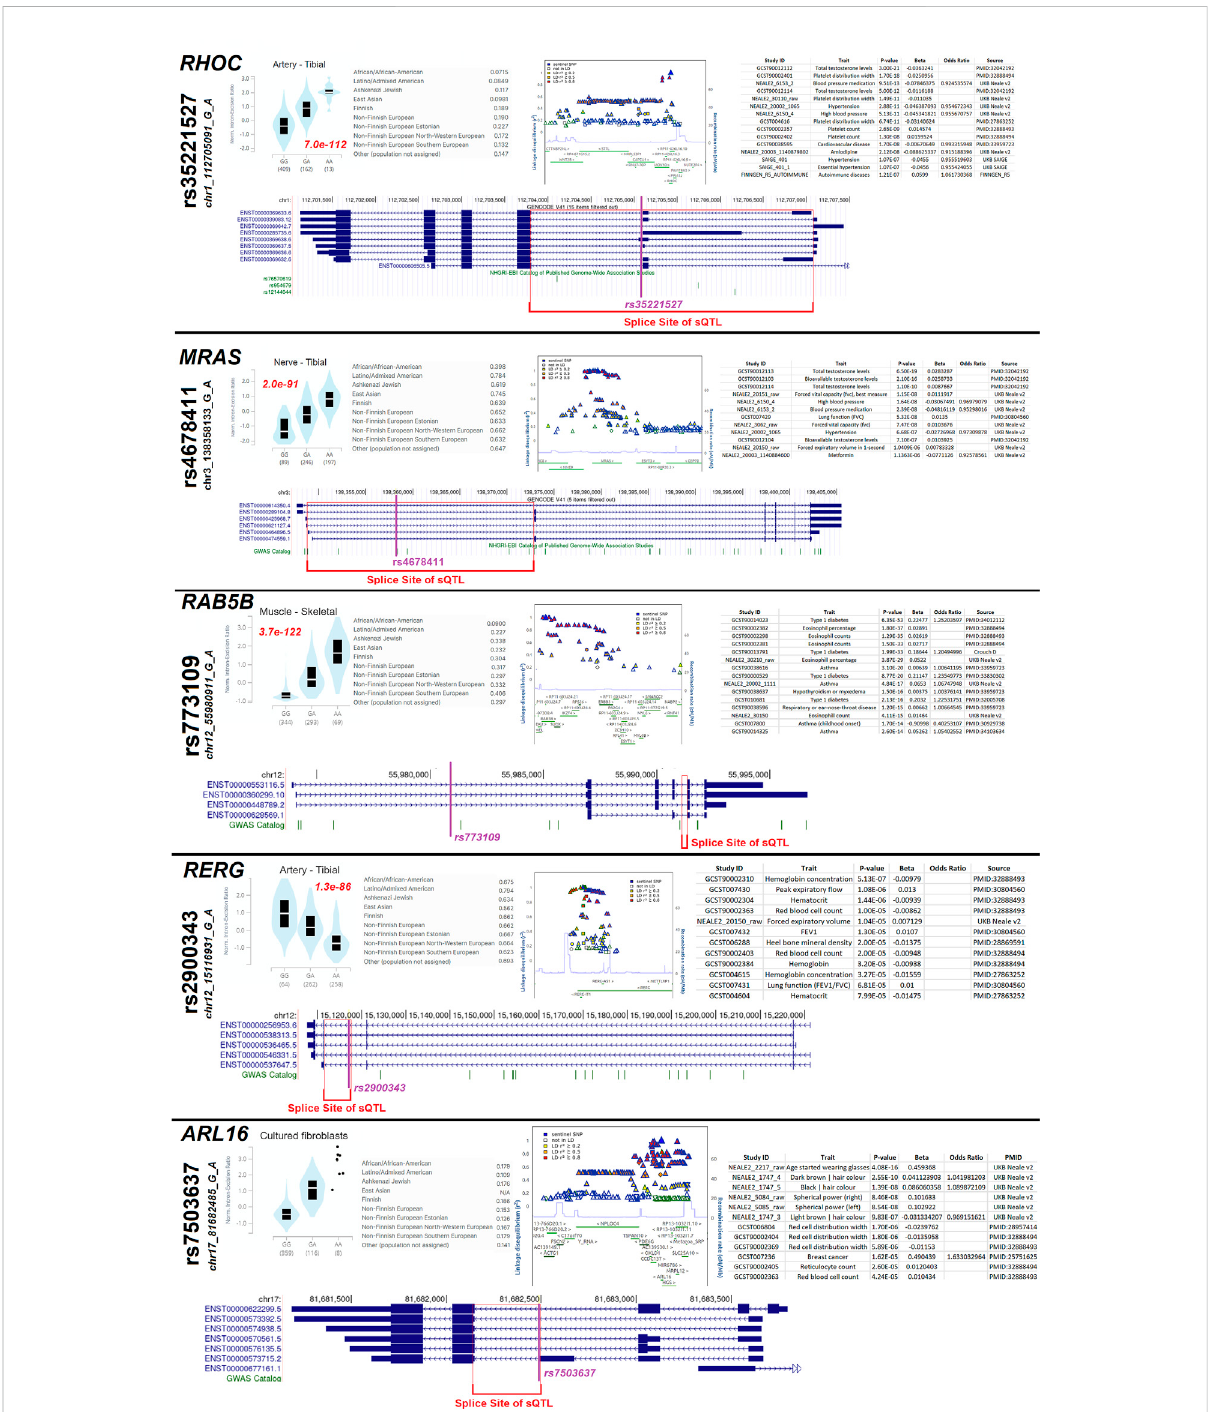
FIGURE 11 Several highly active sQTL loci. Five ( RHOC , MRAS , RAB5B , RERG , ARL16 ) splicing quantitative trait loci (sQTLs) containing small GTPase genes are shown as examples. Each gene has the top tissue plot of homozygous or heterozygous splicing levels next to the rsID and chromosome annotated variant, with the red text listing the nominal p -value. Next to that plot is the minor allele frequency of the top variant for different populations. Next to allele frequency is the plot of linkage disequilibrium SNPs and a list of Open Targets Genetics annotated traits associated with the variant. Below those panels is an exon map annotating the top variant (magenta) and the splicing site annotated as an sQTL